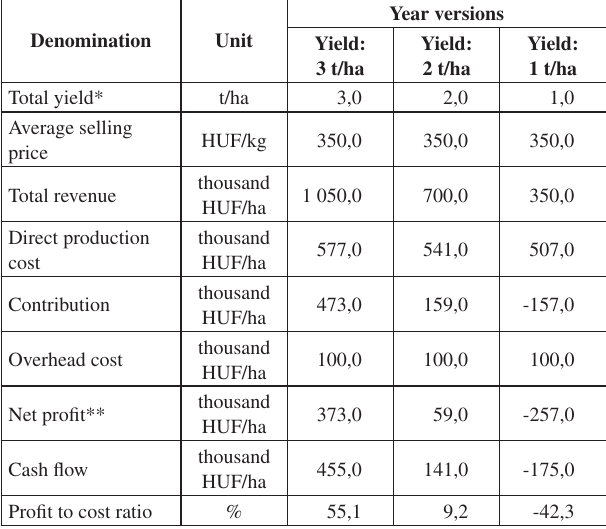
Table 3: Revenue, profit and profitability of walnut orchard cultivated on a good standard in a whole year in case of different year versions